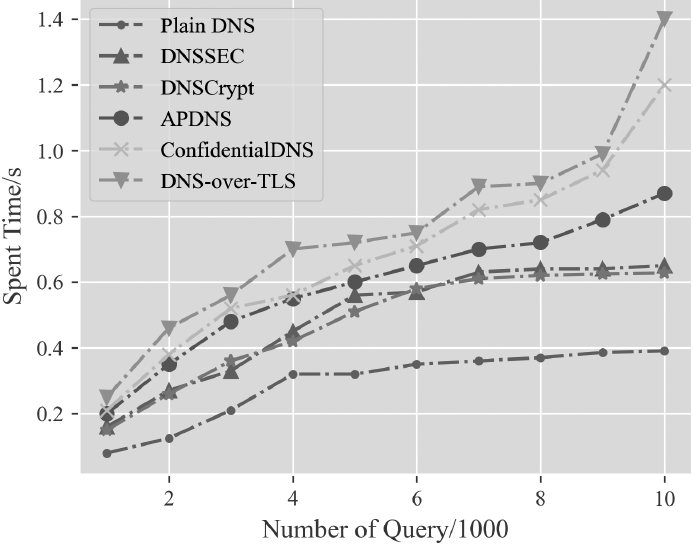
Figure 4. Performance evaluation among kinds of secure DNS resolvers.